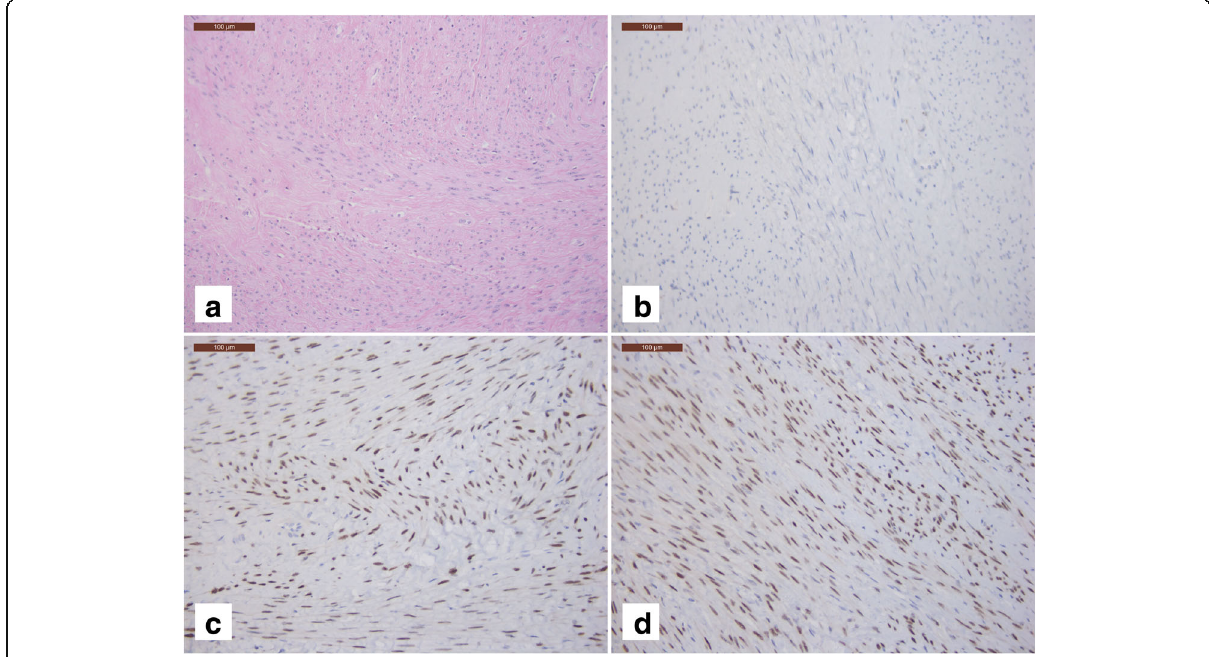
Fig. 4 Leiomyoma with classic morphology from previous hysterectomy specimen, showing intersecting fascicles of cigarshaped, spindle cells with eosinophilic cytoplasm ( a , 200×); CD10 negative immunostaining ( b , 200×); positive nuclear staining for estrogen receptor ( c , 200×), positive nuclear staining for progesterone receptor ( d , 200×)